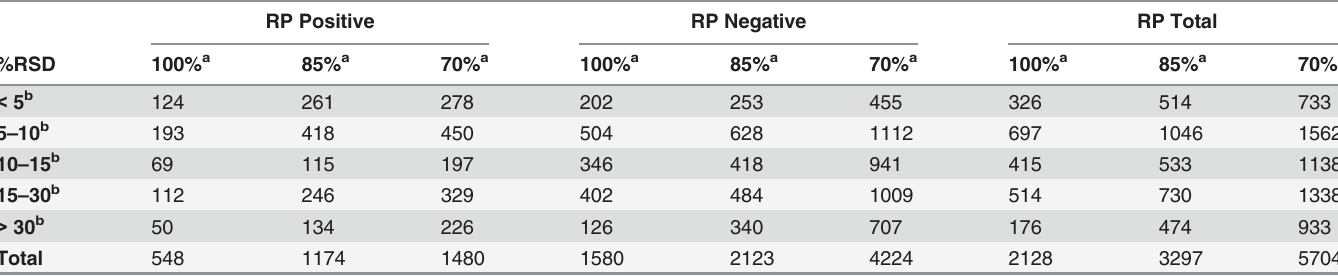
Table 2. Measured metabolite features in the reversed phase method in experiment